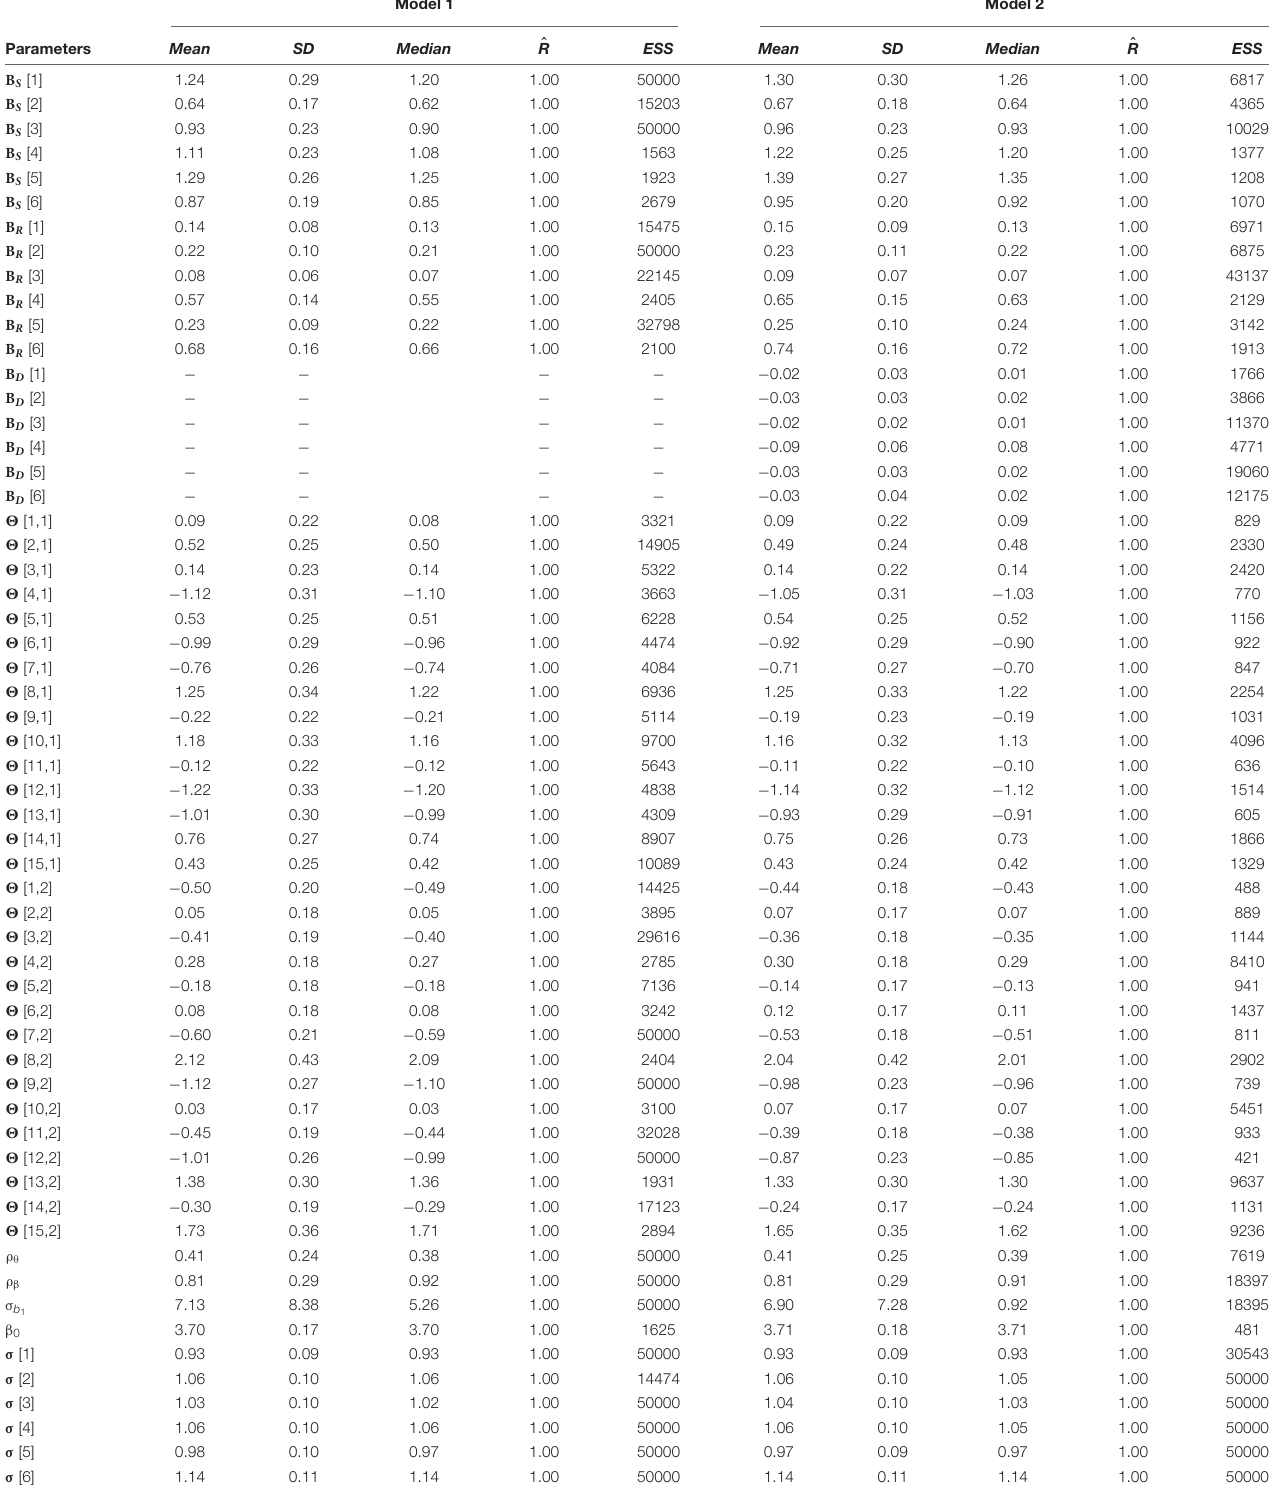
β 0 = the grand mean; B S = the matrix for sender effects; B R = the matrix for receiver effect; ρ β = the correlation coefficient between sender effect and receiver effect; B D = the matrix for effect of distance metric; (cid:50) the matrix for latent trait scores; ρ θ = the correlation coefficient between two latent traits; σ = the matrix for variance of errors; ESS = effective sample